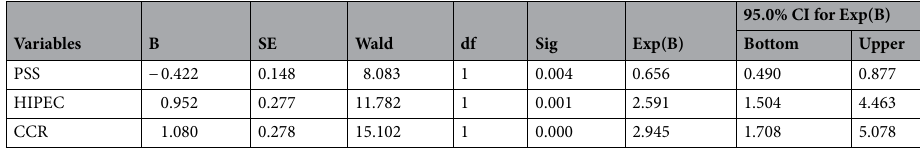
Table 3. Multivariate analysis for statistically significant results (n = 165). PSS prior surgical score, HIPEC hyperthermic intraperitoneal chemotherapy, CCR completeness of